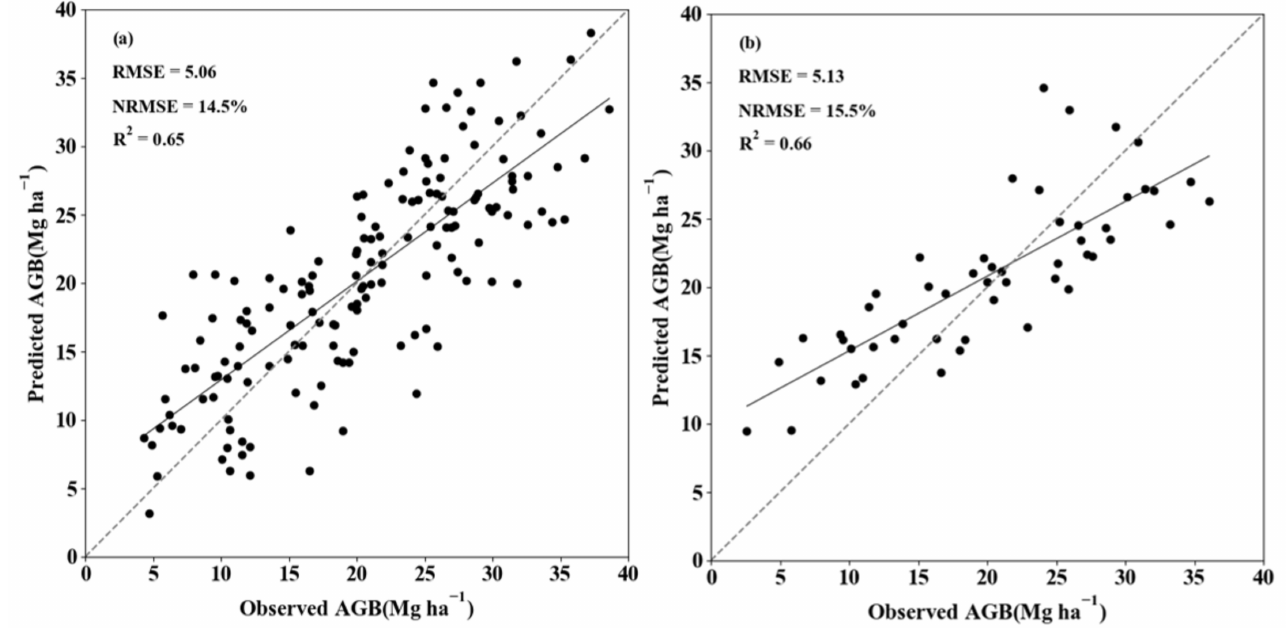
Figure 9. Comparison of observed and predicted AGB by the COK model with ( a ) training samples and ( b ) testing samples.